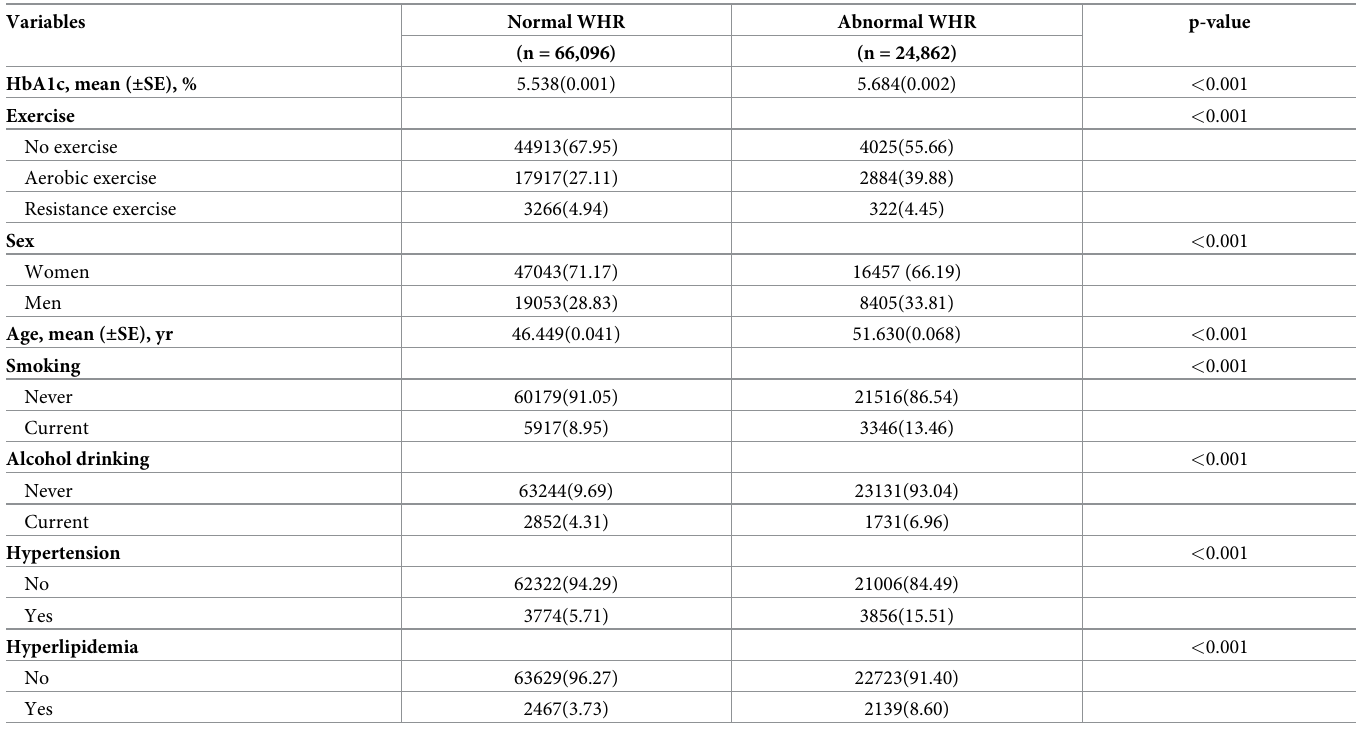
Table 1. Demographic characteristics of participants stratified by WHR.